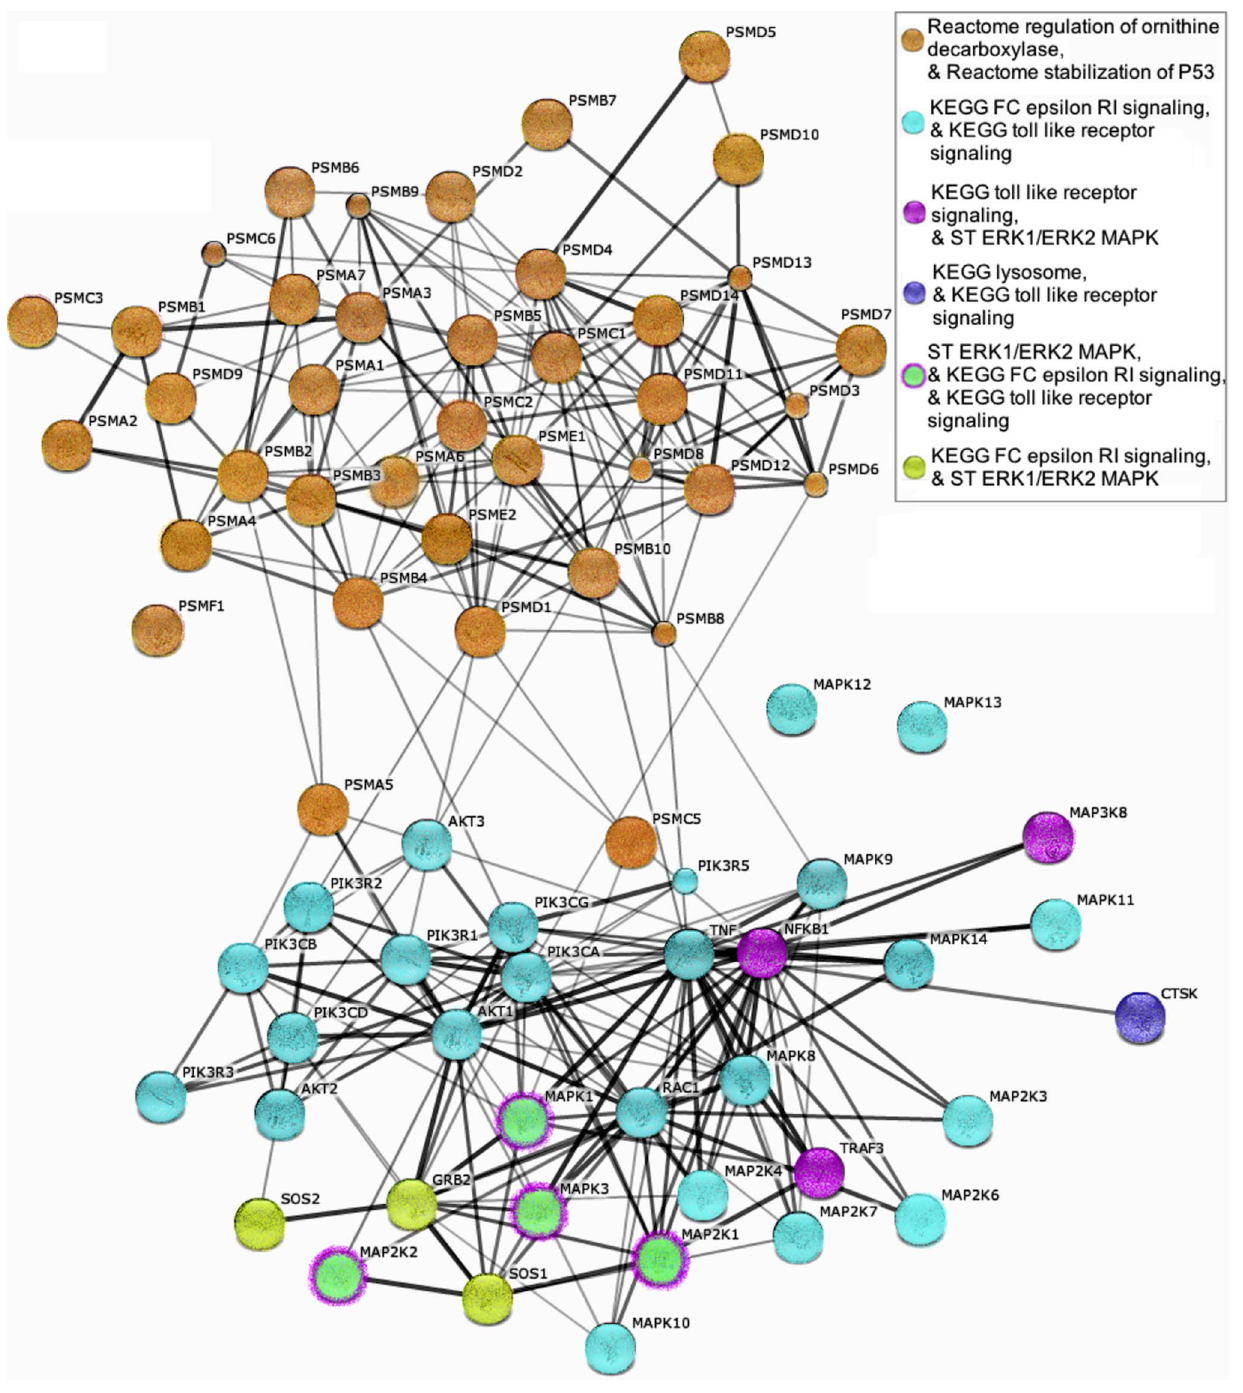
Figure 1. Plot generated using STRING 9.0 (Search Tool for the Retrieval of Interacting Genes). Previously identified protein-protein interactions among genes that are shared across significant pathways. Black edges represent interactions; line thickness is a function of number of previously identified interactions. doi:10.1371/journal.pone.0078546.g001 method recently developed by Jian Yang et al. that estimates the pathway annotation databases; this results in all non-annotated combined effect of multiple SNPs on the heritability of a trait using genes being automatically excluded from analysis. Our analysis of only summary statistics [50]. A second limitation of our analysis is identified protein-protein interactions was dependent upon inter- due pathway and protein-protein interaction annotation being actions listed in PubMed and OMIM. Due to current limits in incomplete. Several thousand genes are not yet included in any knowledge of human genes and their regulation the information in